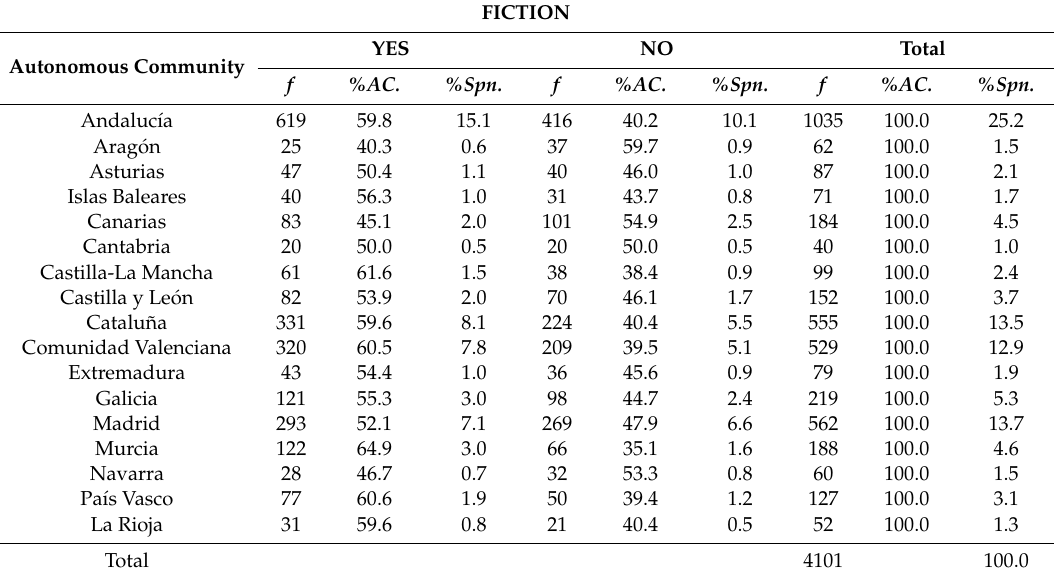
Table 4. Percentages and frequencies of fiction films seen by teacher (cid:48) s degree students, according to the Autonomous